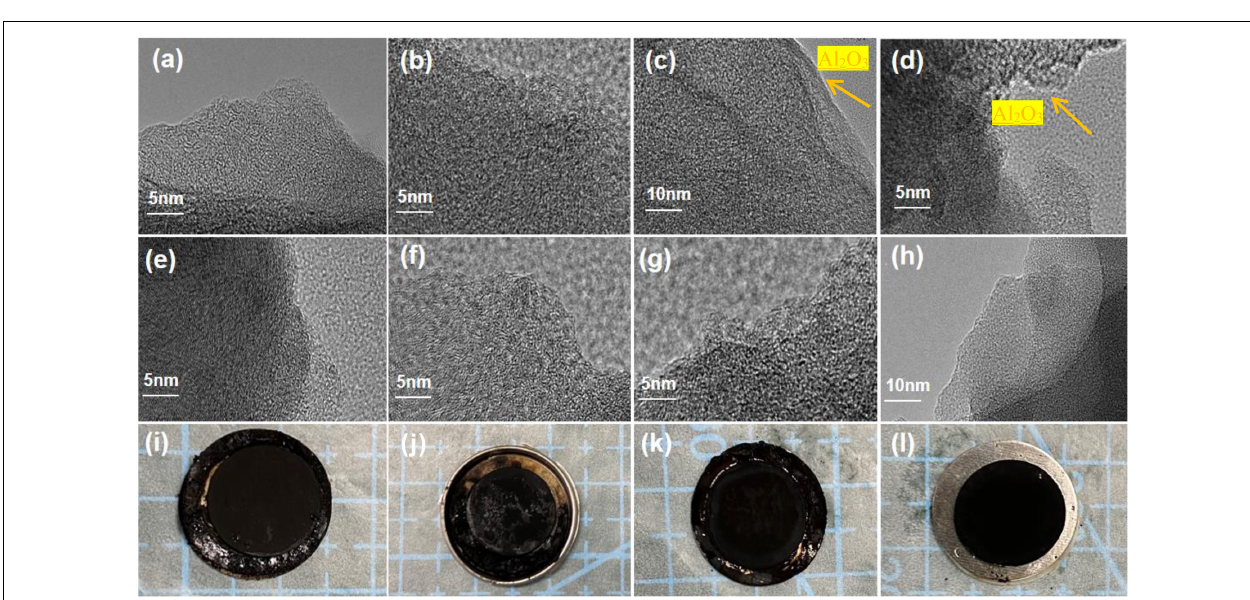
FIGURE 6 | TEM image of fresh electrode: (a) Bare AC; (b) OP-15; (c) ALD-OP15; (d) OP15-ALD; TEM image of electrodes after 5,000 cycles: (e) Bare AC; (f) OP-15; (g) ALD-OP15; (h) OP15-ALD; and (i–l) optical images of four electrodes after the cell dissection.